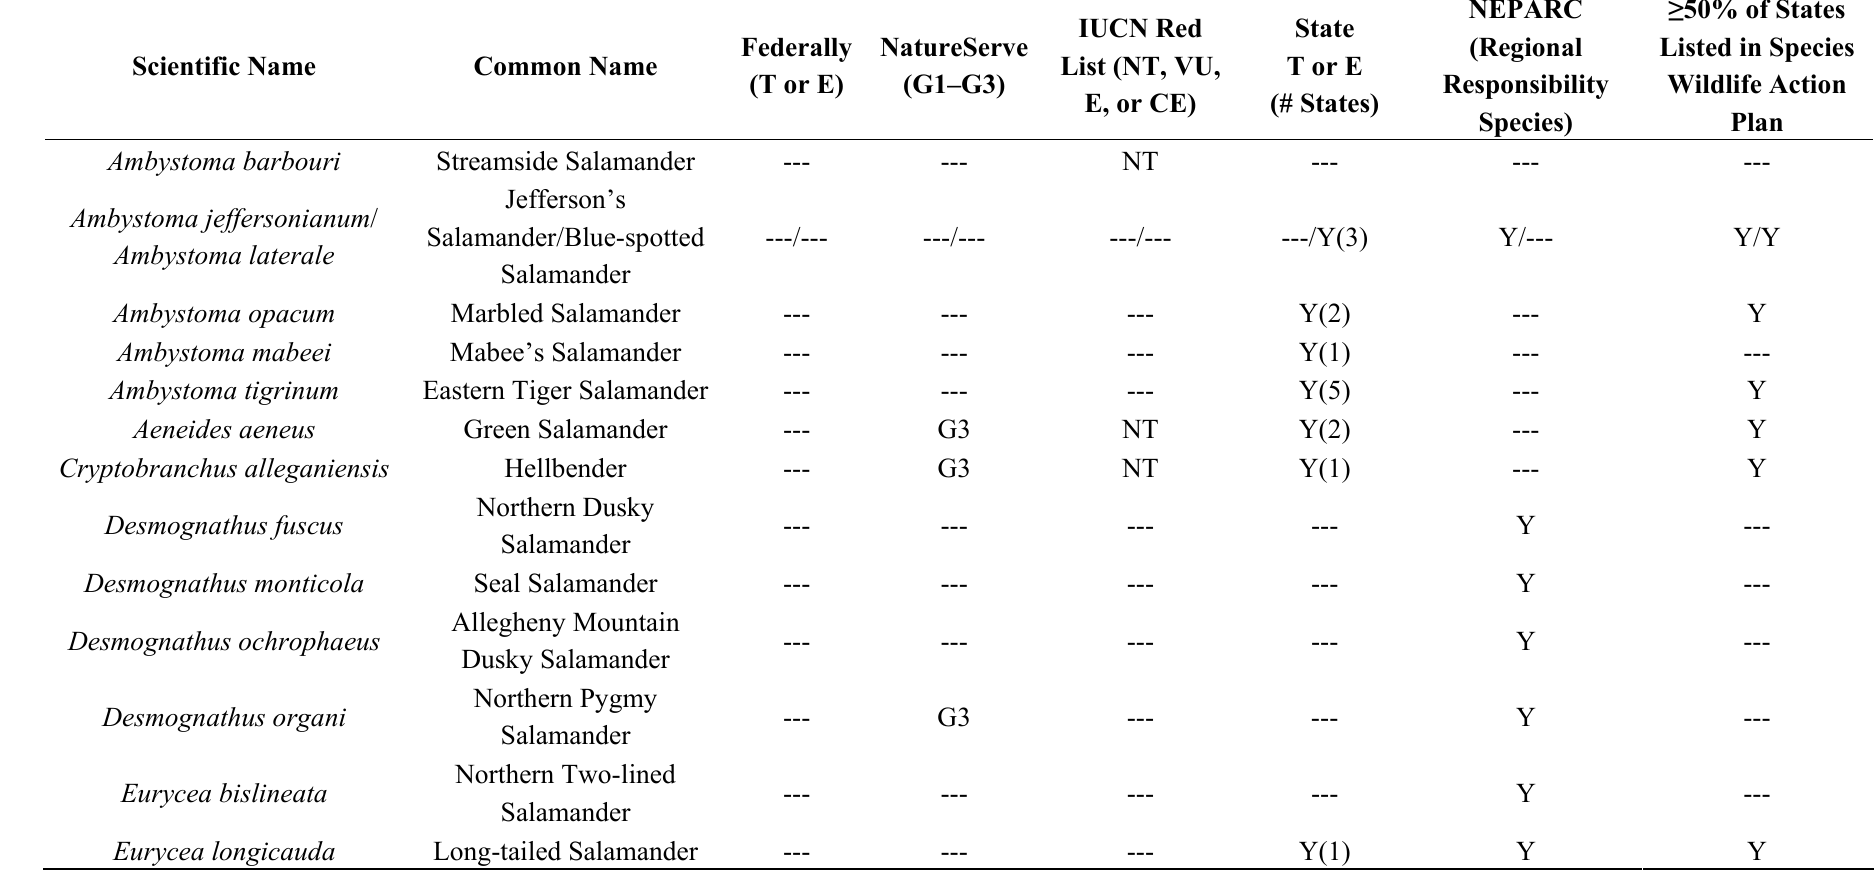
Table 3. Conservation rankings for priority salamander species in the North Atlantic Landscape Conservation Cooperative and the Northeastern Partners in Amphibian and Reptile Conservation (NEPARC) regional networks. Abbreviations are as follows: IUCN (International Union for the Conservation of Nature), T (Threatened), E (Endangered), NT (Near Threatened), VU (Vulnerable), CE (Critically Endangered), and G1–G3 (Natureserve Global Conservation Ranks). The number in parentheses under the “State” ranking refers to the number of states in the northeastern U.S. that a given species is Threatened or Endangered. A ranking of “Y” in the last two columns denotes whether a species is a NEPARC regional responsibility species and is listed in ≥50% of northeastern state Wildlife Action